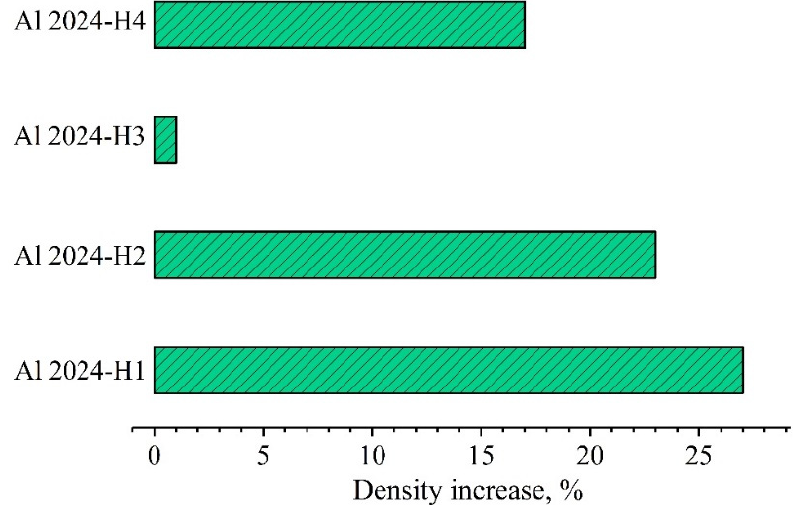
Figure 2. Density increases (%), with respect to base matrix alloy, Al 2024 aluminum alloy.